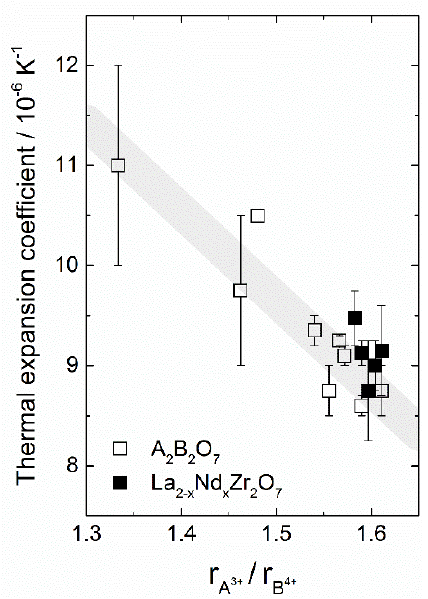
Figure 7. Linear thermal expansion coefficients of the A 2 B 2 O 7 oxides as a function of their cation radii ratio. The coefficients have been taken from Table 6 and the uncertainties represent the respective ranges in values given.